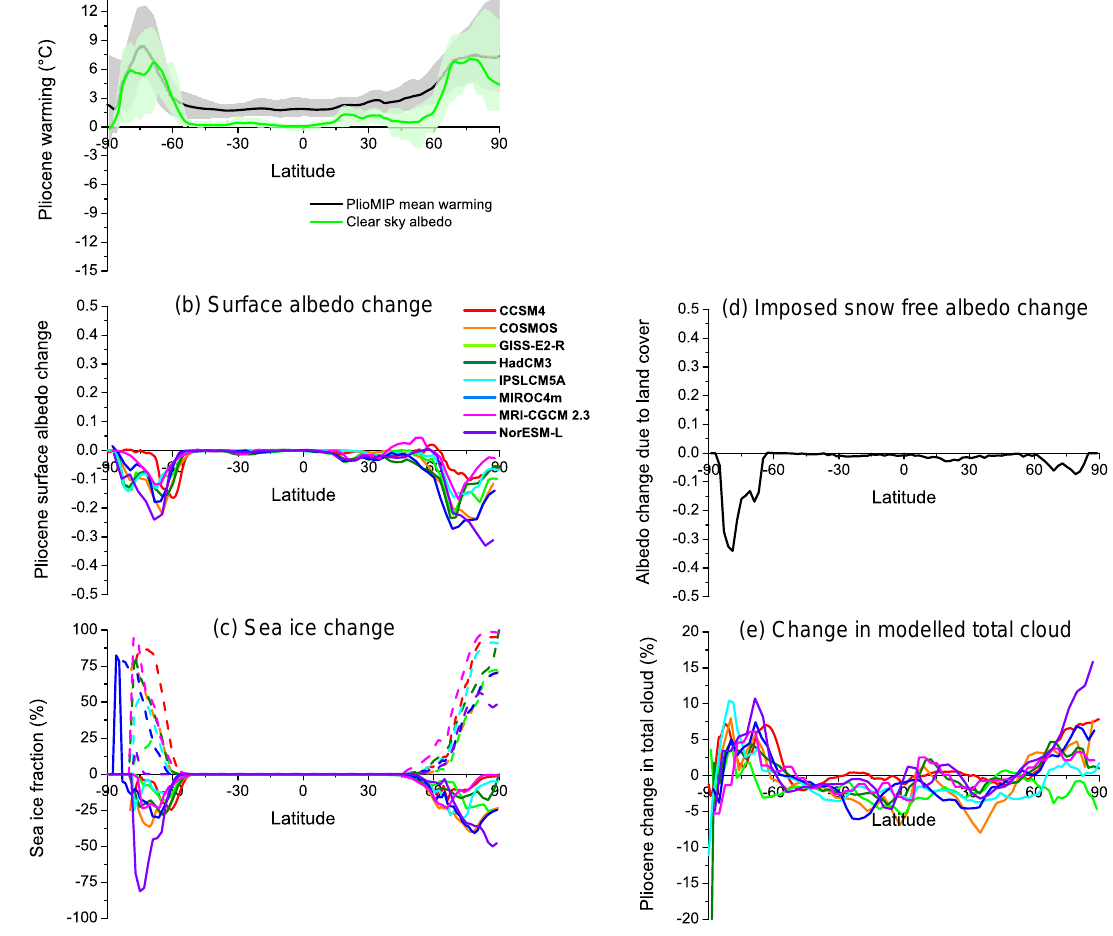
Fig. 7. Zonal mean of a series of factors that contribute to the clear sky albedo and its impact on Pliocene warming. (a) The total Pliocene Fig. 6. Spatial distribution of multi-model mean changes in the clear warming and the clear sky albedo component of this (black and green respectively; see Fig. 4). (b) Total zonal surface albedo change in each sky albedo between mid-Pliocene and pre-industrial simulations. of the 8 models. (c) Zonal mean sea ice percent coverage in the models, solid line is the Pliocene total and the dashed line is the change This primarily shows changes due to specified vegetation and global between Pliocene and pre-industrial experiments. (d) Imposed snow free albedo change, as calculated from the observed and reconstructed Pliocene mega-biomes, which include vegetation and ice sheet changes (Salzmann et al., 2008; Haywood et al., 2010). (e) Change in modelled ice sheets and modelled sea ice and snow cover, although it includes total percent cloud cover for each model. These are calculated by each of the models using their own algorithm and cloud parameterizations, an atmospheric component. Greyscale shows reductions in albedo, so are indicative rather than directly generally associated with warming and yellow shading indicates in- creases in albedo that would generally cause a reduction surface air temperature. Increases in albedo closely follow the northward ex- pansion of grassland imposed on the simulations (Haywood et al., 2010).